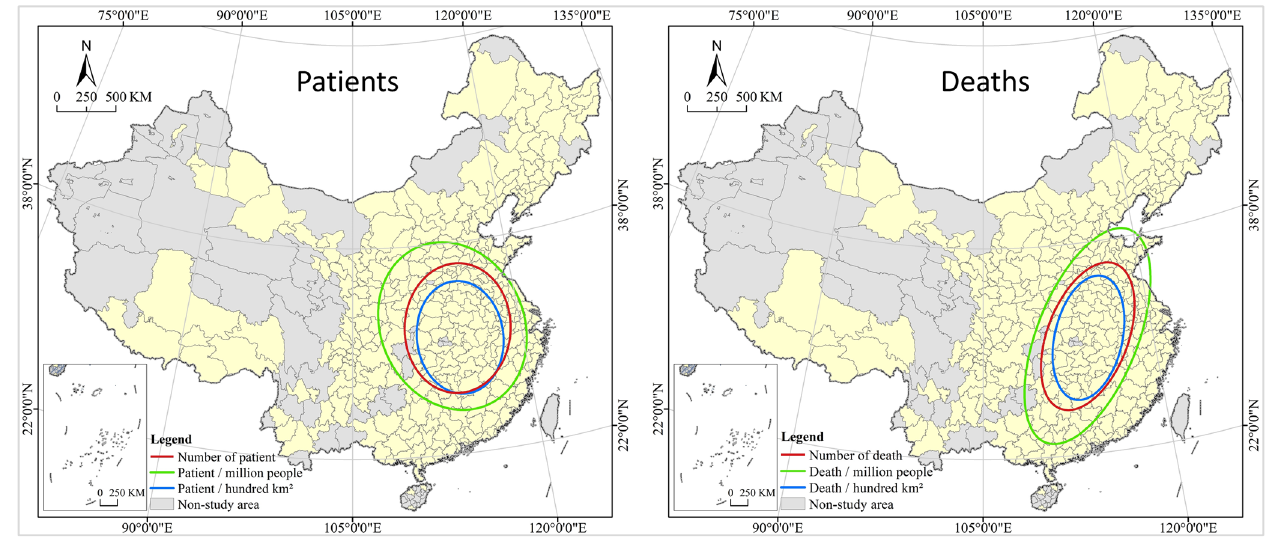
Figure 6. Standard deviation ellipse analysis of COVID-19 in China cities.